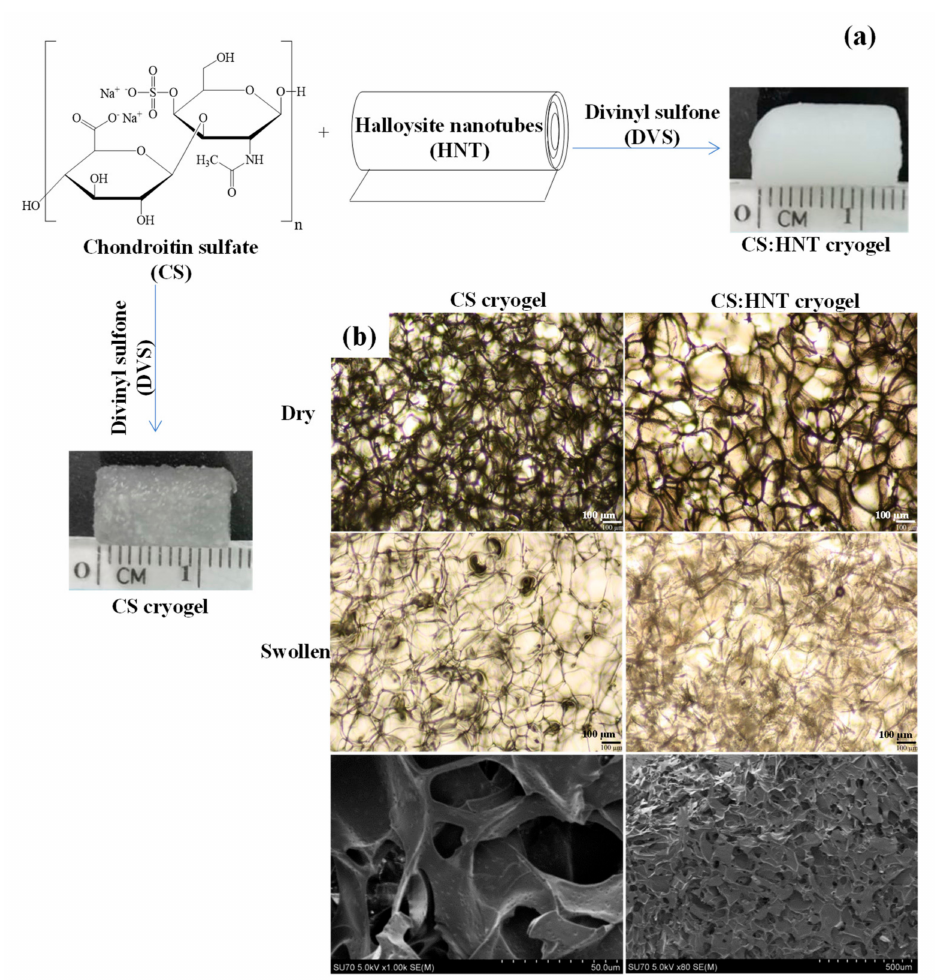
Figure 1. ( a ) Schematic representation of cryogels synthesis, and ( b ) the optic microscope images of dry and swollen cryogels and the corresponding SEM images of the